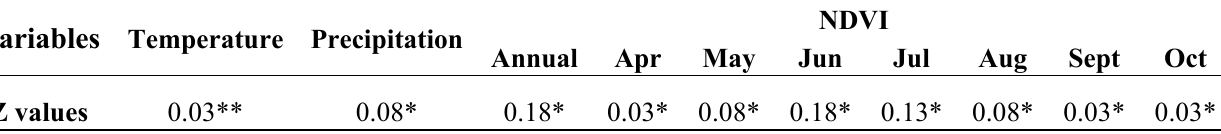
Table 3. The trends of annual NDVI, temperature, and precipitation throughout the growing season, and monthly NDVI from April to October indicated by the Z values during the period of 1985–2007 in